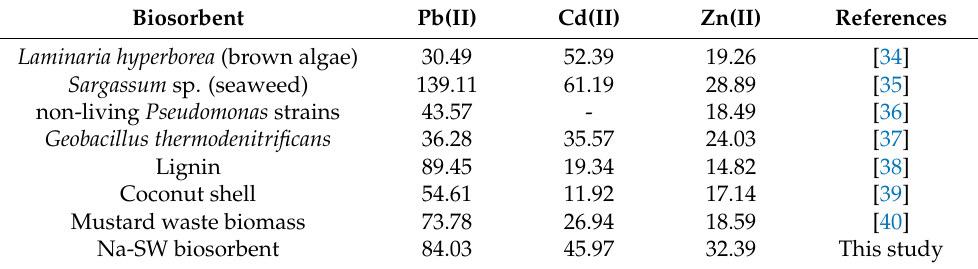
Table 3. Comparison of the maximum biosorption capacity of Na-SW biosorbent for studied metal ions with different biomass-based